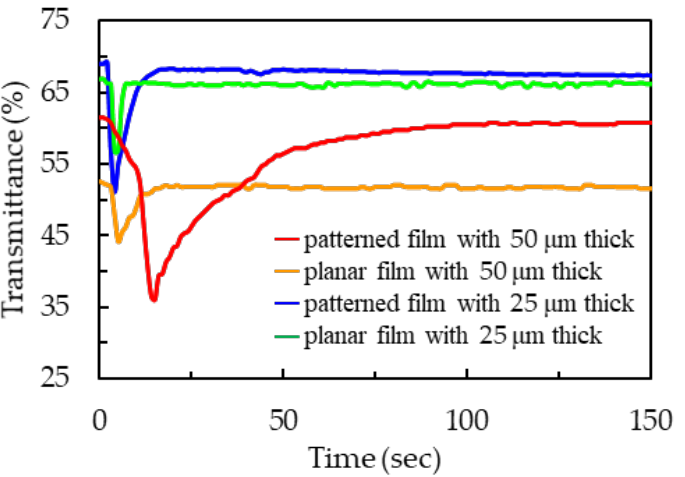
Figure 6. Time-dependent transmittance curves of the PDLC films with different thicknesses and surfaces that were exposed to acetone.